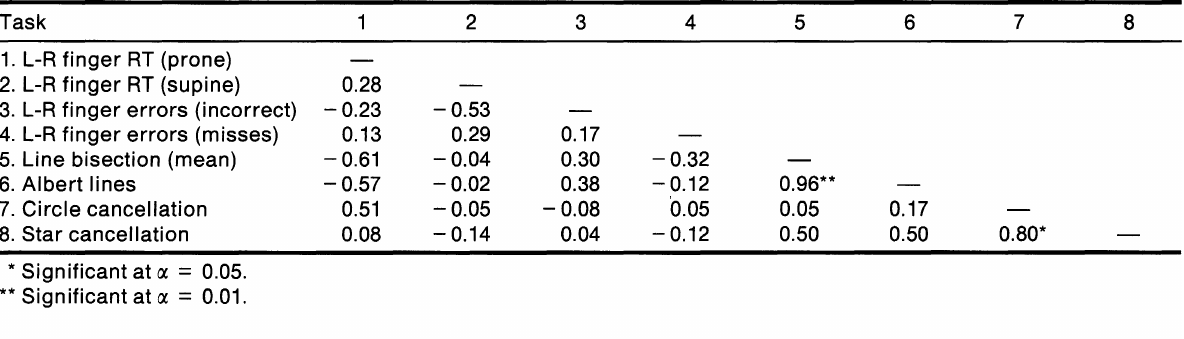
TABLE III. Pearson product-moment correlation coefficients for cancellation, line bisection, left/right finger reaction time differences, and left/right finger error differences